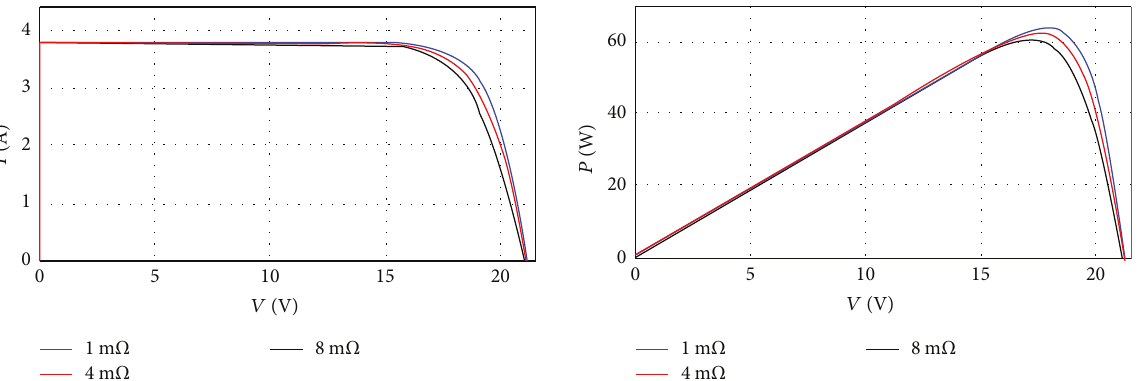
Figure 9: I ‐ V and P ‐ V curves for di ff erent values of R